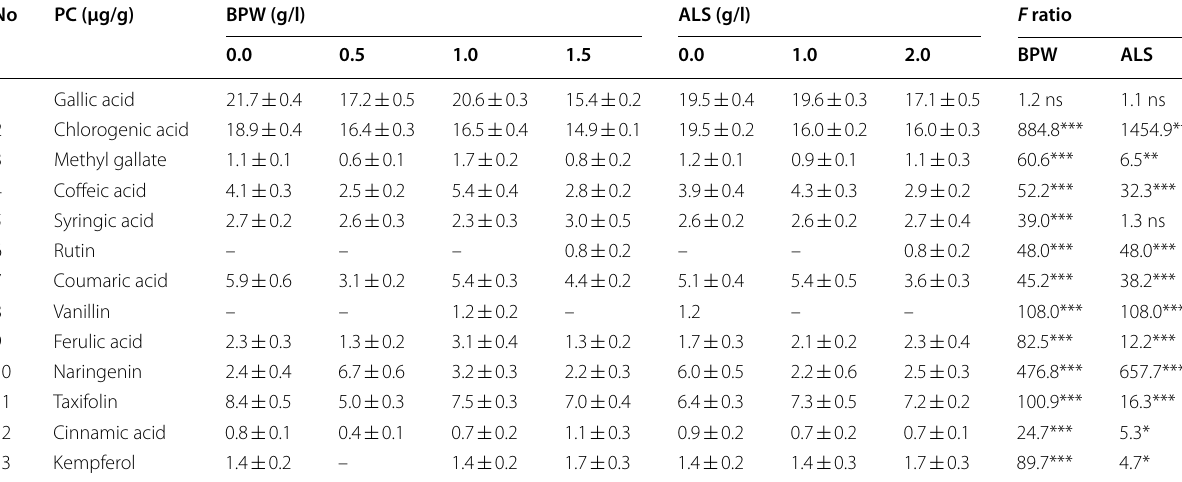
* P < 0.05 (significant), ** P < 0.01 (moderate significant), *** P < 0.001 (highly